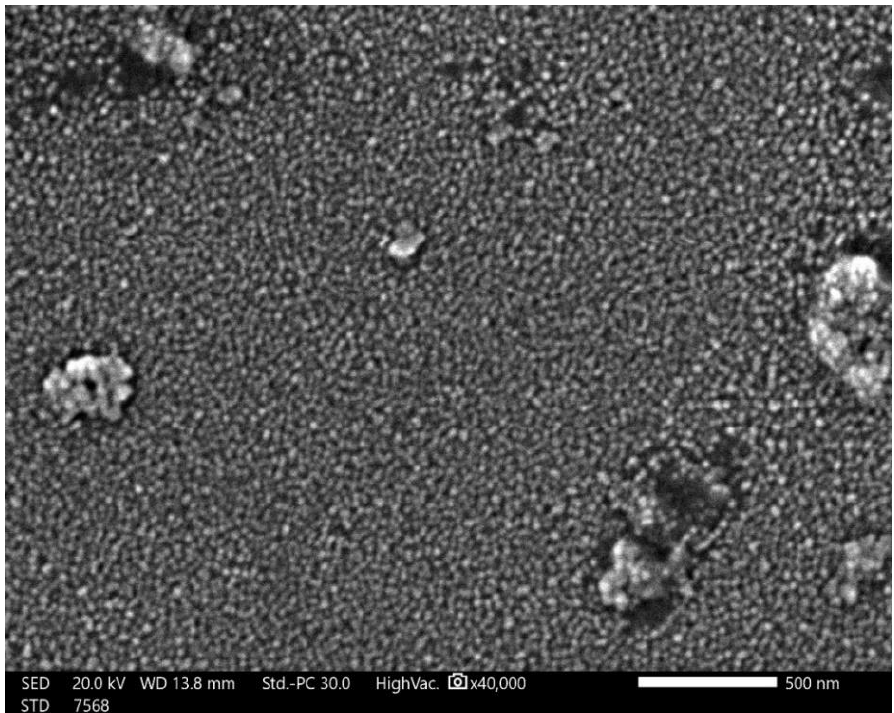
Figure 5. SEM micrograph for the raw material powder of the ZrO 2 nanoparticles used as a reinforcing material for the acrylic matrix.